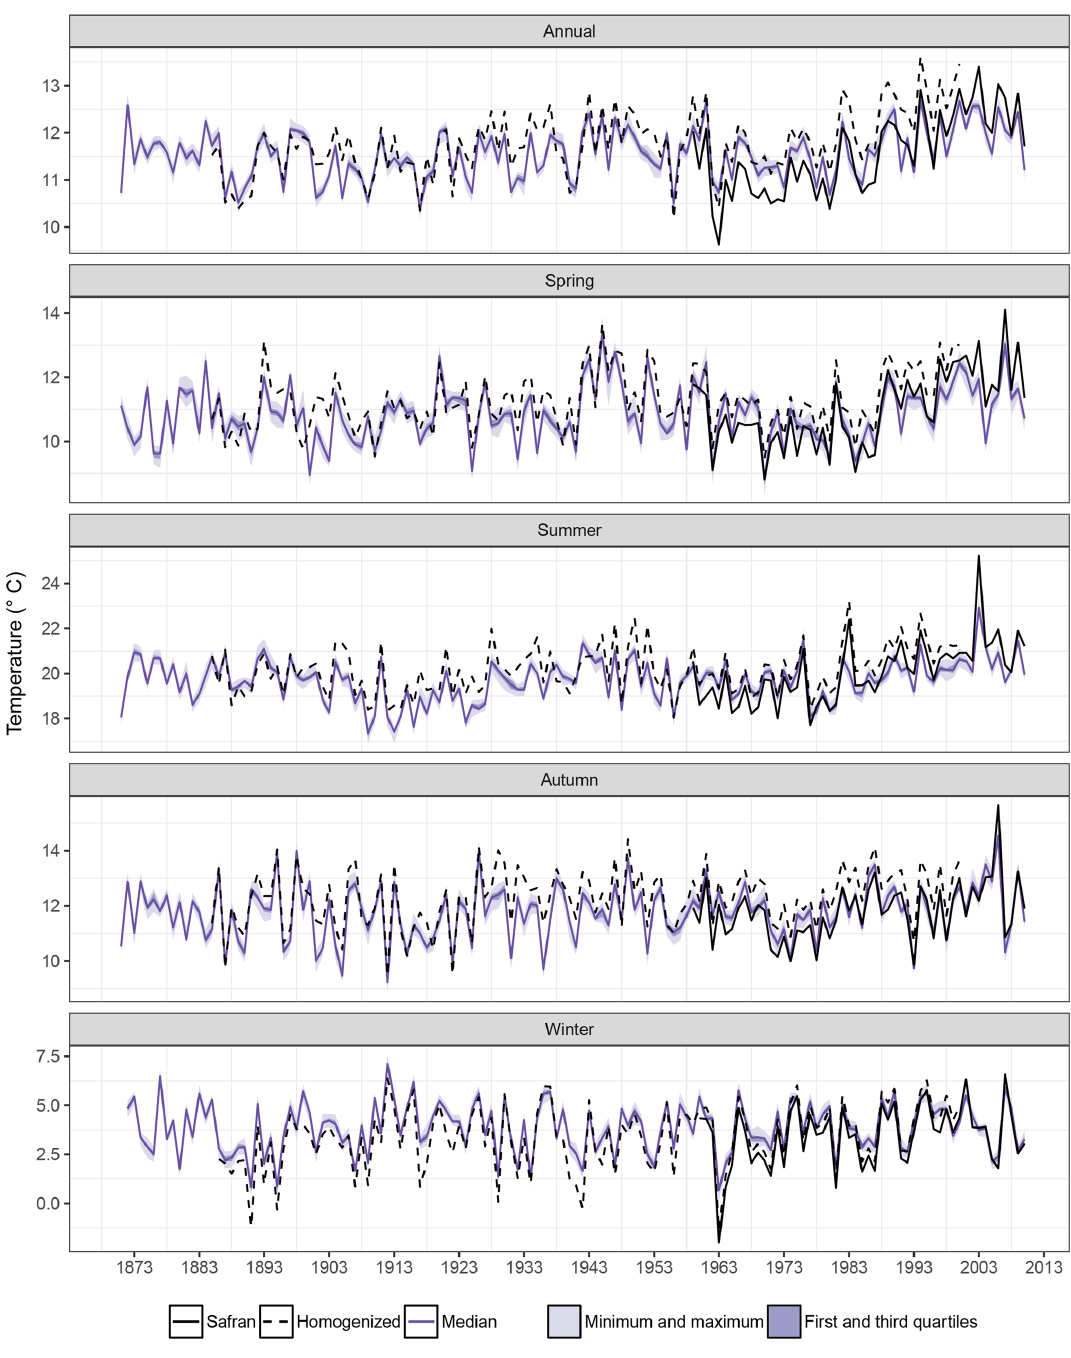
Figure 6. As for Fig. 5, but for temperature.